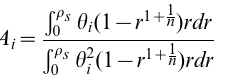
Figure 1. Validation of our algorithm. We compare our local Nusselt number of a non-slip Newtonian fluid in a tube with that in the previous work for testing the algorithm.